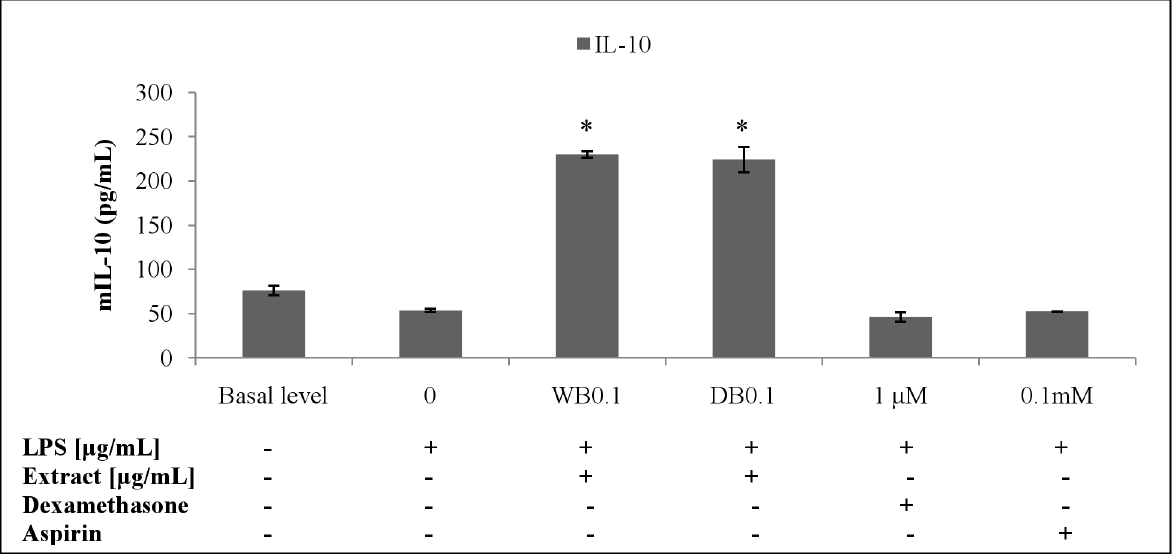
Fig 9. Effects of A . rugosum extracts on IL-10 cytokine level (S1 Dataset). RAW264.7 cells were co-incubated with A . rugosum extracts (WB0.1: 0.1 μ g/ mL WB; DB0.1: 0.1 μ g/mL DB) and 1 μ g/mL LPS for 24 hrs. Dexamethasone (1 μ M) and aspirin (0.1 mM) served as positive controls. Results shown represent the mean ± SD, n = 3 and * p < 0.05 versus LPS-induced NO level alone.